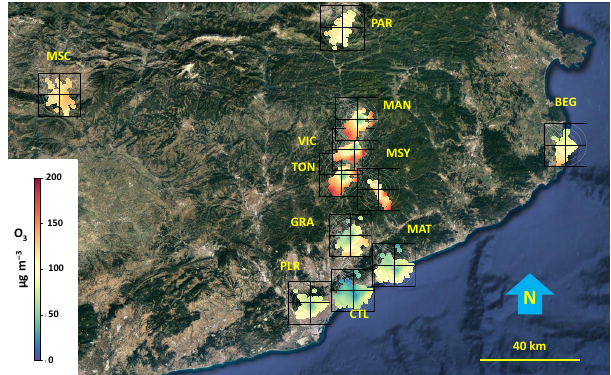
Figure 6. Polar plots of hourly O 3 concentrations at the real-time measurement